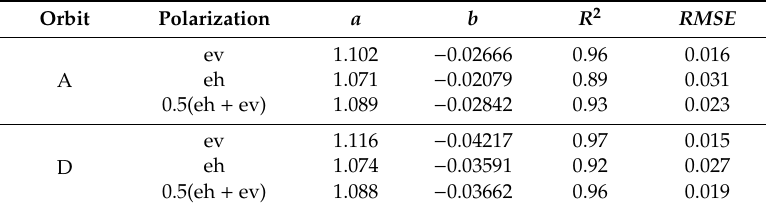
Table 2. The fitted coe ffi cient and statistical error of SMAP L3 SSM and estimated SSM from SMAP L3 dataset based on the change detection algorithm developed here.